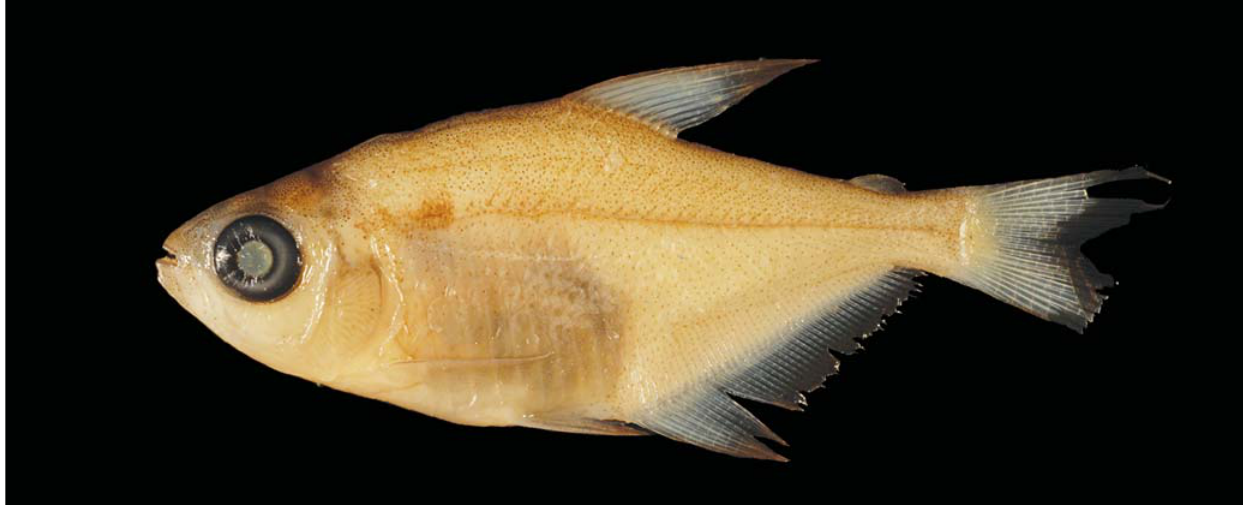
Fig. 3. Astyanax erythropterus (juvenile), MACN-ict 9453, 29.9 mm SL, Argentina, Provincia de Entre Ríos, Parque Nacional Pre-Delta, río Paraná basin.